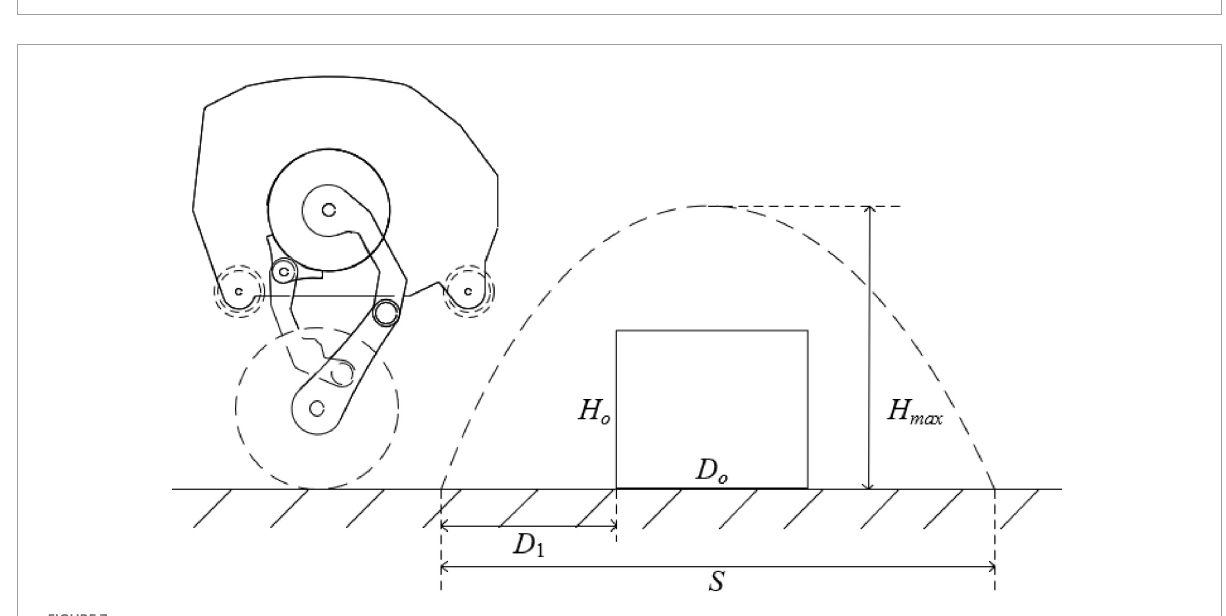
FIGURE7 Schematic diagram of the robot over the